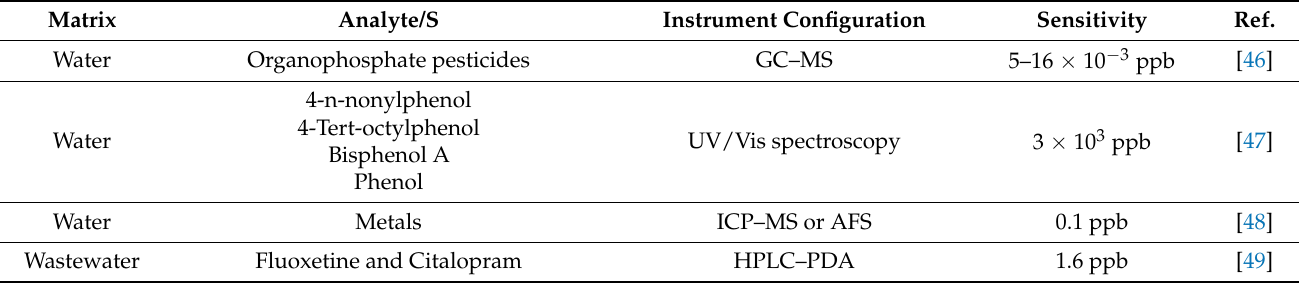
Table 2. List of key developments in instrument